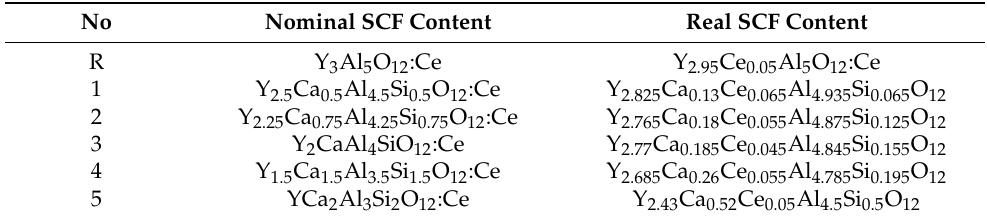
Figure 2. Dependence of the segregation coefficient of Ca 2+ (1) and Si 4+ (2) ions at growth of Y 3 − x Ca x Al 5 − y Si y O 12 :Ce SCFs onto YAG substrates when changing nominal Ca (x) and Si (y) content in melt solution in the 0.5–2 range and SCF growth temperature in the 960–1020 ◦ C range (see Table 1). Table 1. Nominal (in melt solution) and real (in film) content of Y 3 − x Ca x Al 5 − y Si y O 12 and YAG: Ce SCFs, LPE grown on YAG substrates by using PbO-B 2 O 3